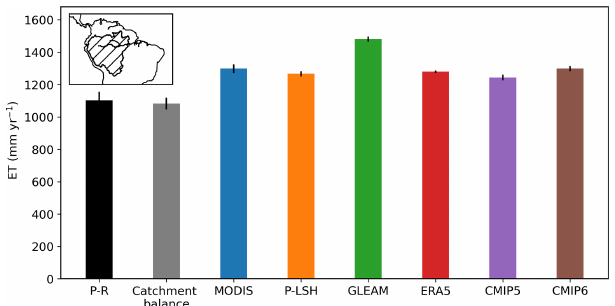
Figure 2. Comparison of annual Amazon evapotranspiration (ET) estimates. Climatological mean Amazon ET estimated from water-balance approaches (precipitation minus runoff, P − R , and catchment-balance accounting for change in groundwater storage, P − R − d S ), satellites (MODIS, P-LSH, and GLEAM), ERA5 re- d t analysis, and climate models (CMIP5 and CMIP6). Data are from 2003 to 2013 with the exception of CMIP5, for which data are from 1994 to 2004. Error bars represent the interannual standard deviation for each dataset. For CMIP5 and CMIP6, the error bars represent the average standard deviation across all models. Data from satellites, reanalysis, and models were averaged over the re- gion shown in the inset map for a direct comparison with the water- balance